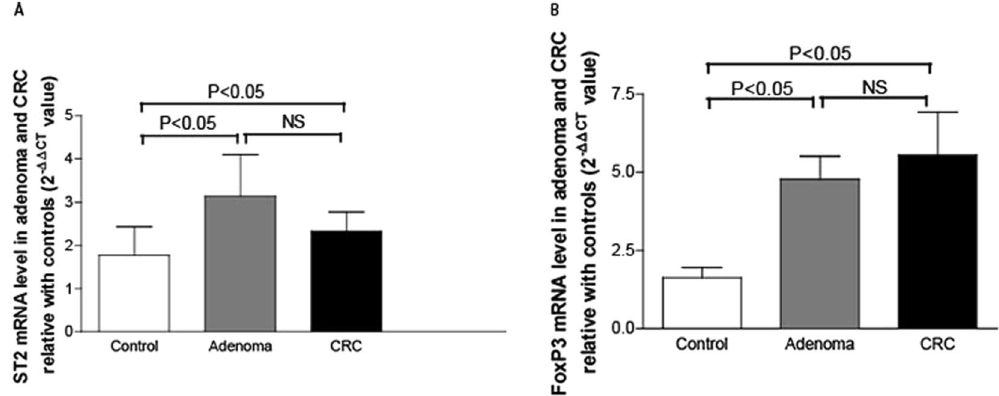
Figure 1. mRNA expression level of ST2 and FoxP3 in the adenomas and CRC tissues. The mRNA expression level of ST2 determined by real-time PCR was significantly increased in the adenoma tissues ( grey bar in A ) compared to the normal controls ( white bar in A , P < 0.05). It was also significantly higher in the CRC tissues ( black bar in A ) than in the normal controls ( white bar in A , P < 0.05) but slightly lower than that in the adenoma tissues ( grey bar in A ). As seen in B , the expression level of FoxP3 mRNA showed an increasing trend along the adenoma-carcinoma sequence. Increased expression of FoxP3 mRNA was started from the adenoma stage ( grey bar in B ) and even higher in the CRC stage ( black bar in B ) compared to the normal controls ( white bar in B , both P < 0.05). NS: no significant, P >